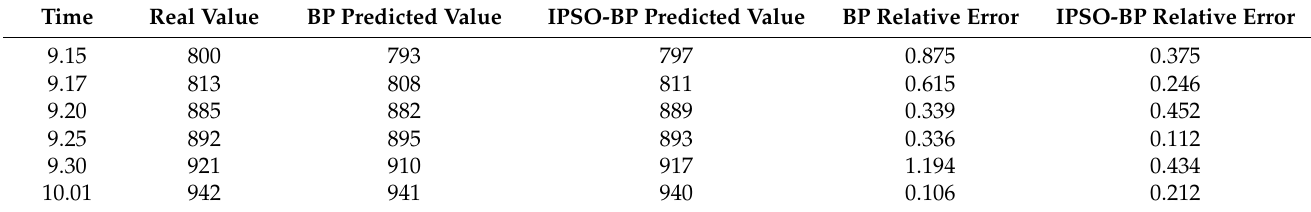
Table 3. Comparison between the IPSO-BP neural network and the BP neural